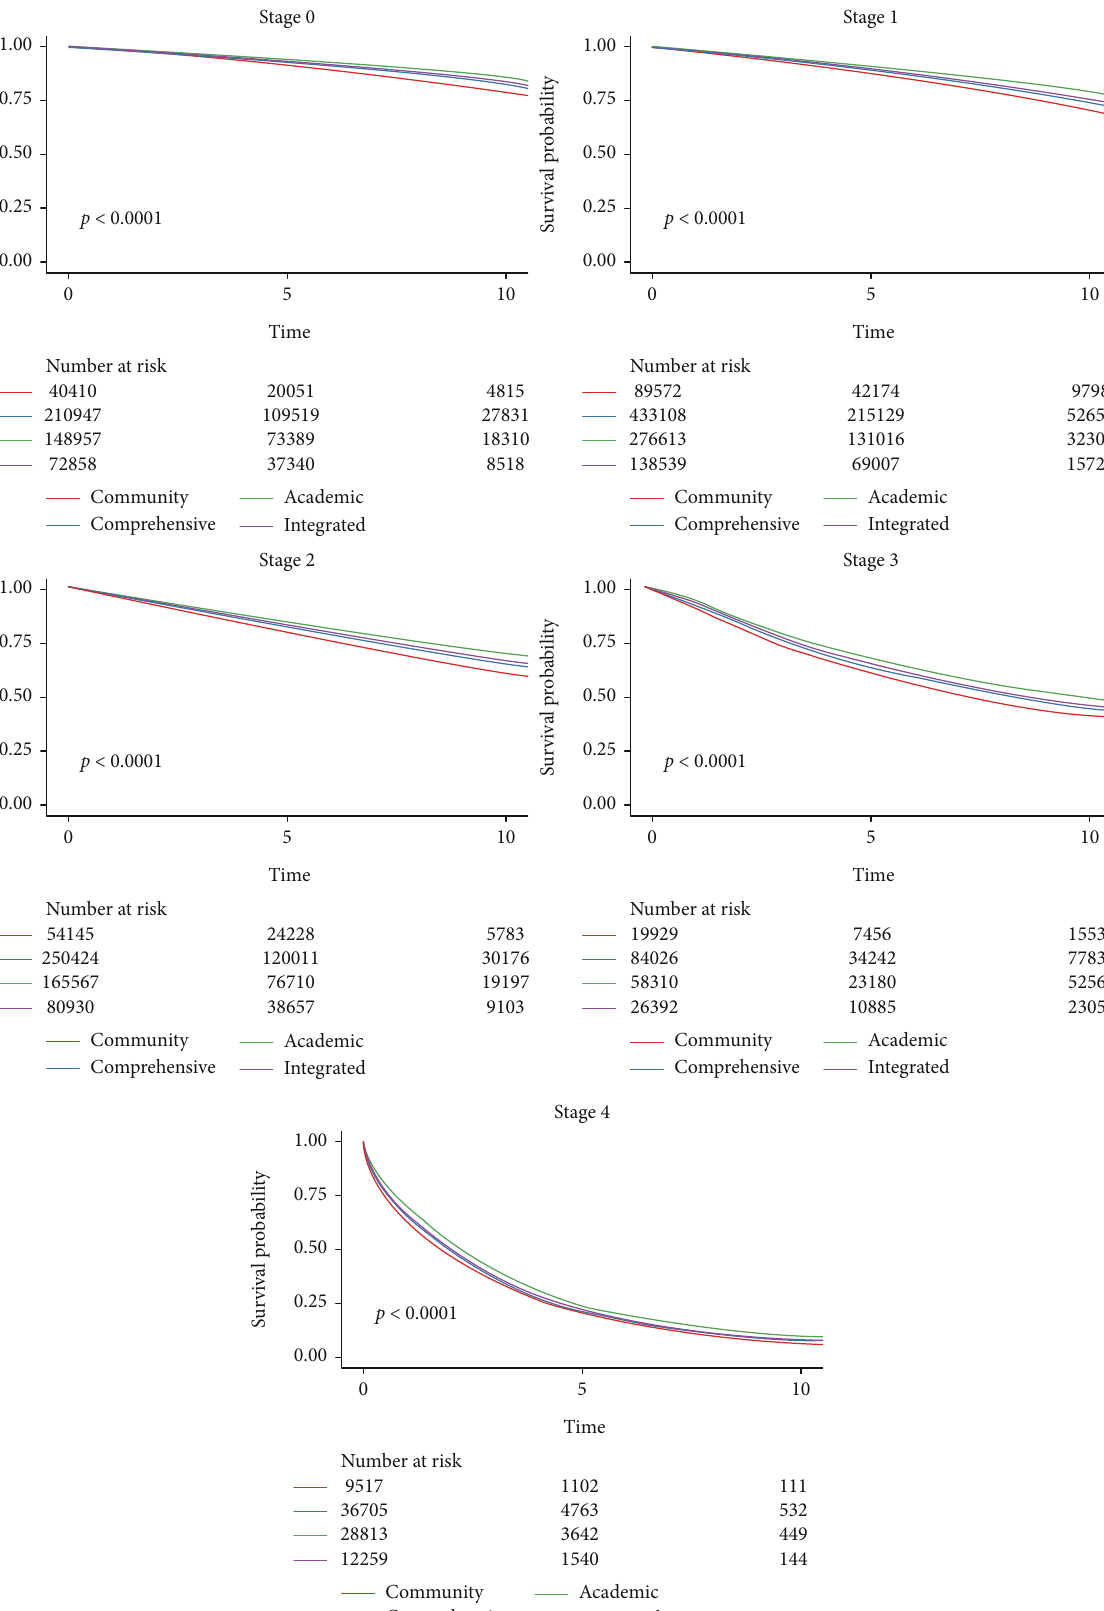
Figure 2: Kaplan-Meier survival curves strati fi ed by facility type and